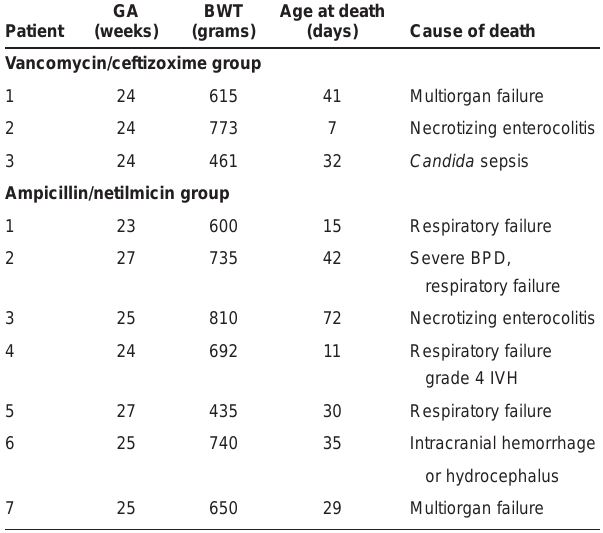
TABLE 3 Characteristics of patients who died GA